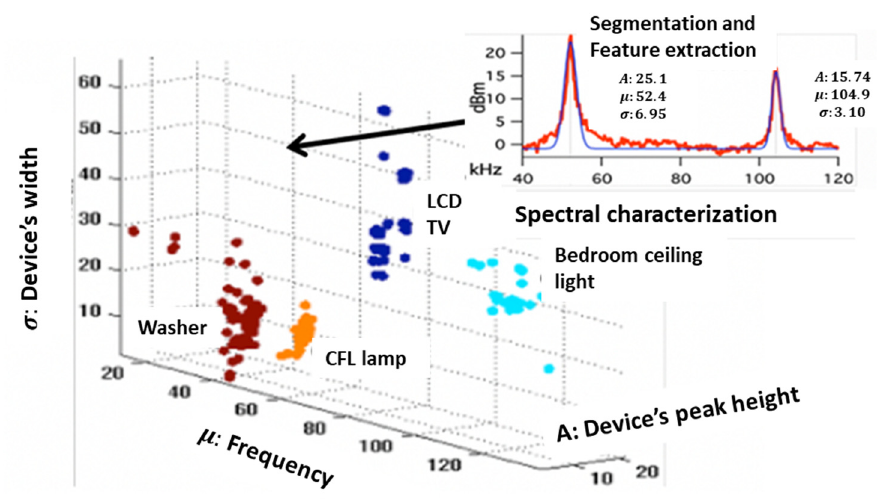
Figure 4. Projecting the first peak of each electric device onto the three-dimensional space to obtain a single device